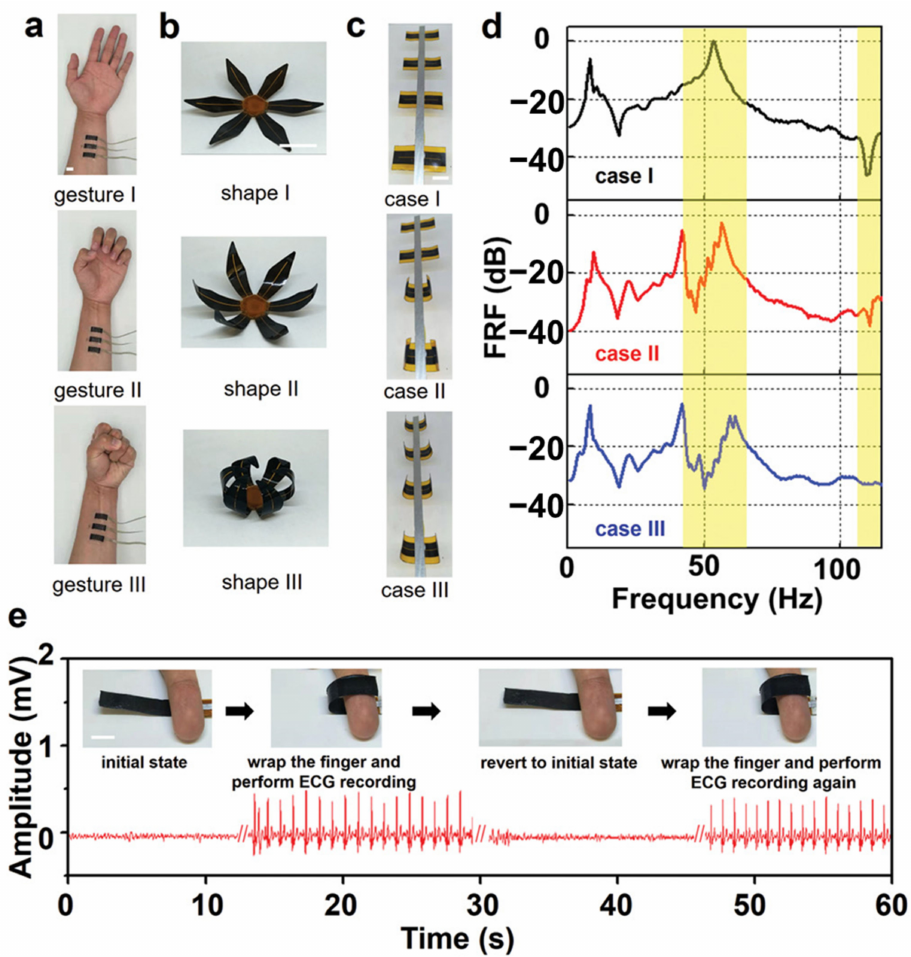
Figure 6. The electrothermally controlled soft actuators for on-demand gesture interaction and ECG monitoring. ( a ) Human gestures are used to control the 3D assembly of a ( b ) flower-like structure and ( c ) shape reconfiguration of an elastic metamaterial for ( d ) tunable bandgap behaviors. ( e ) A soft robotic finger which can wrap the human finger for ECG measurement in an on-demand and reversible fashion. Scale bars: 1 cm. Reproduced with permission from [19]. Copyright 2020